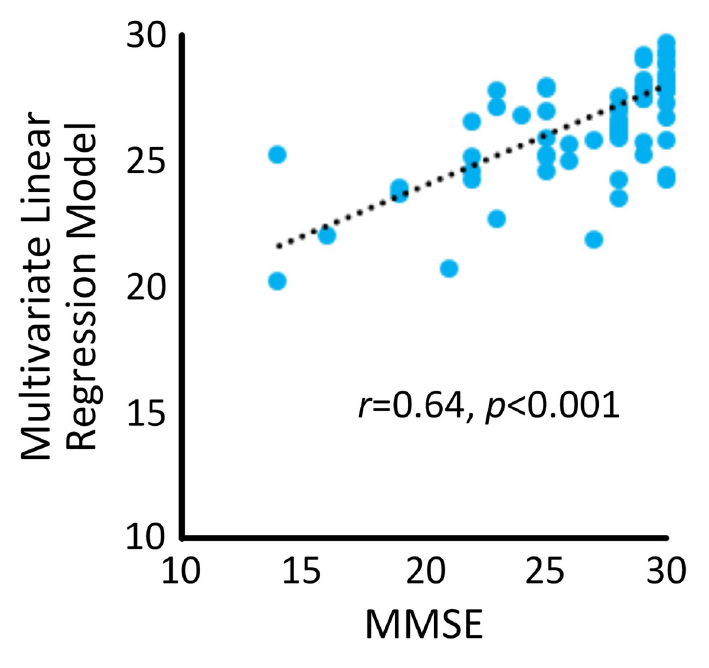
Fig 4. A significant correlation was observed between the multivariate linear regression model and MMSE.